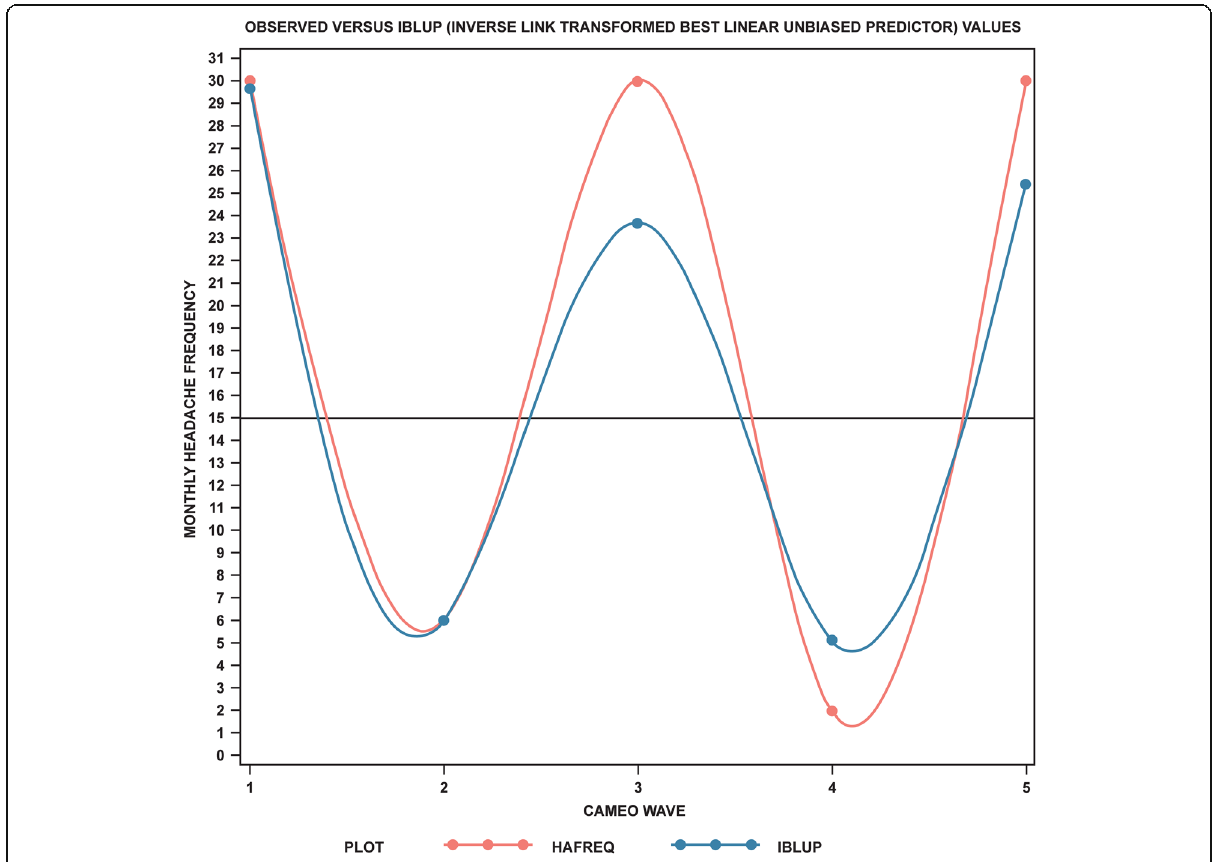
Fig. 3 Observed monthly headache frequency over 15 months compared with that predicted using IBLUP = approach HAFREQ = observed monthly headache frequency: IBLUP = inverse link function best linear unbiased